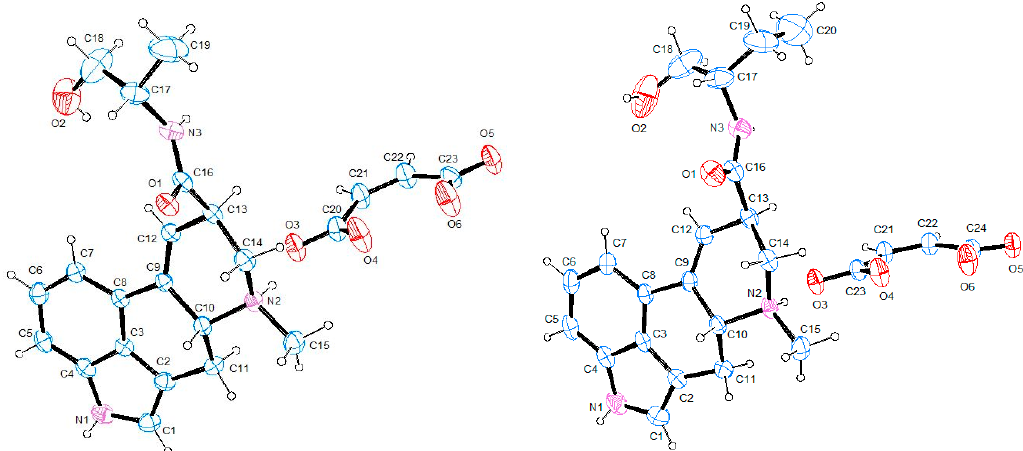
Figure 4. ORTEP drawings [19] of 6 ( left ) and 7 ( right ), with the arbitrary atom numbering (ellipsoids are at 40% probability and H atoms are represented as spheres of arbitrary radii).